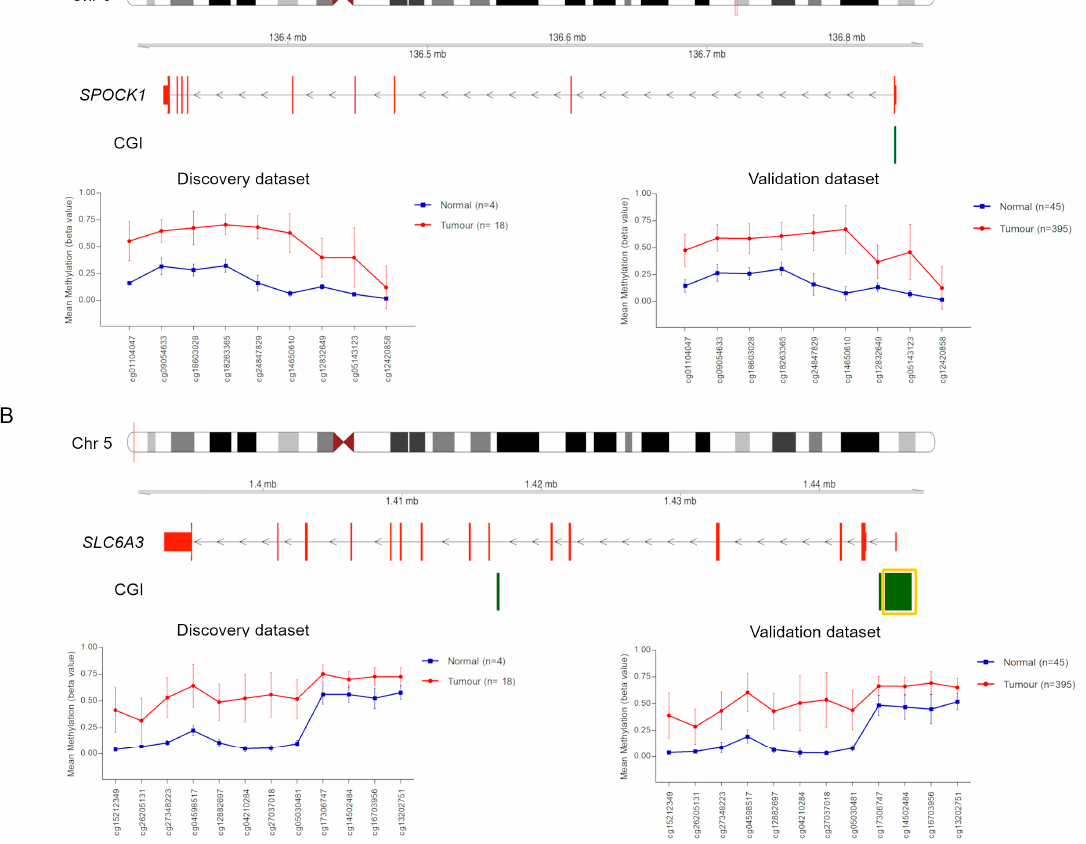
Figure 2. Methylation values obtained from our CRC discovery set and TCGA validation set. Genomic organization of SPOCK1 ( A ) and SLC6A3 ( B ), including the localization of exons and CGIs. Mean β values, resulting from the average of the samples (normal and tumour) of each probe mapping on the altered CGIs associated with SPOCK1 ( A ) and SLC6A3 ( B ). When more than one CGI is shown, the altered one is enclosed in a yellow